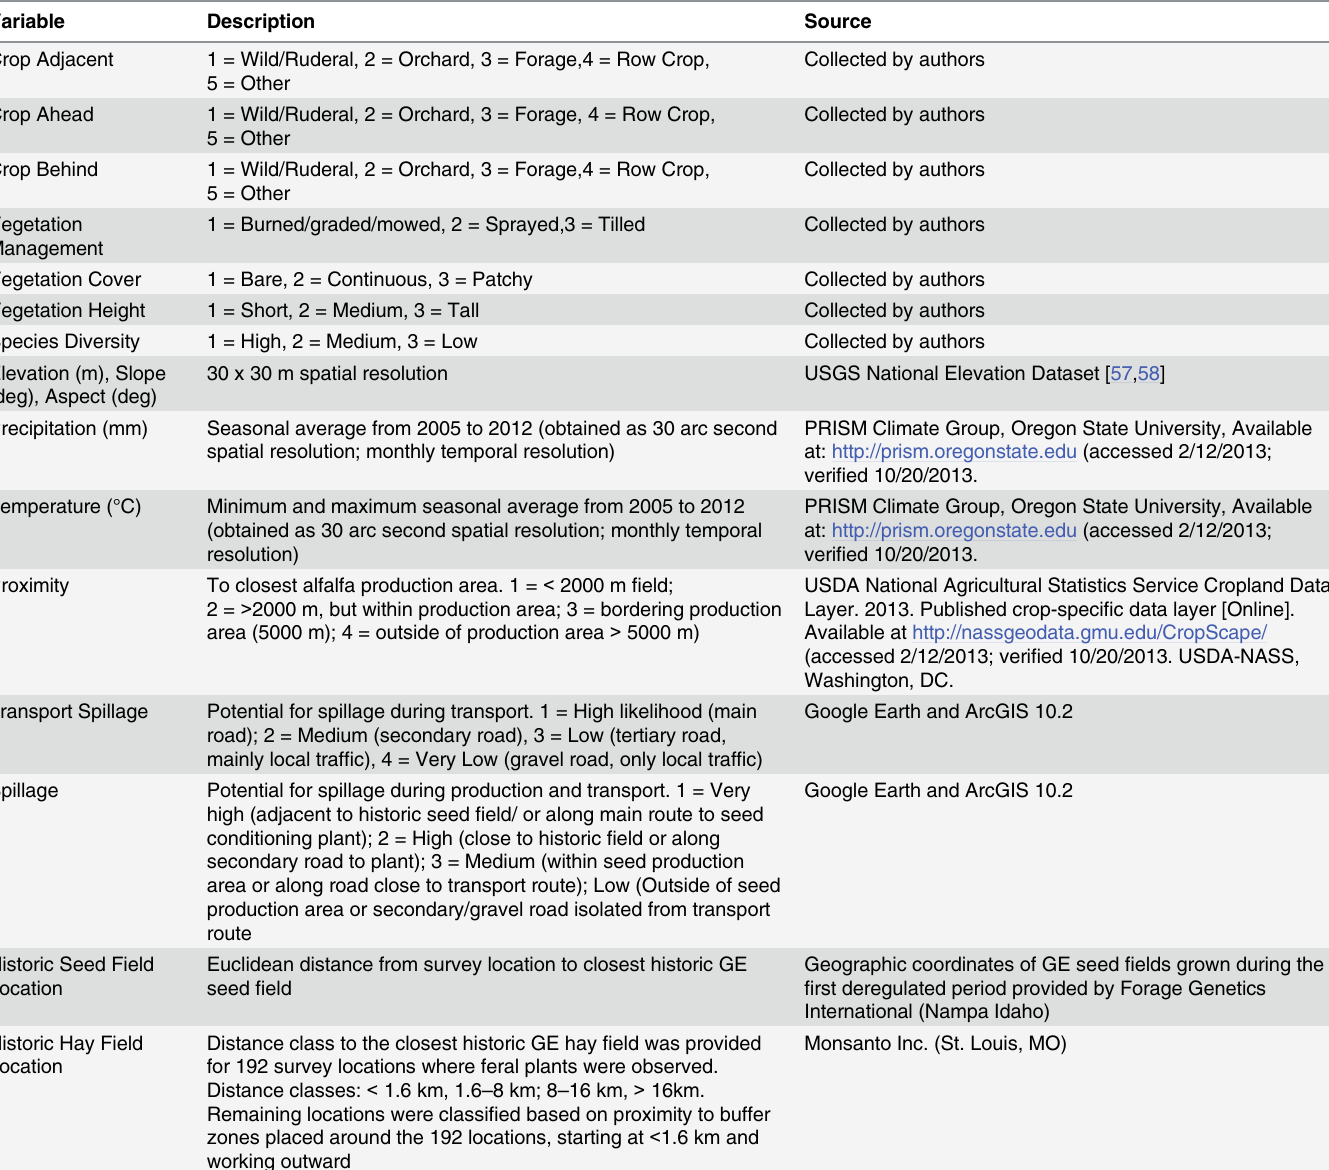
Table 2. Variables used in generalized linear model explain the occurrence of feral populations and transgenic feral populations growing along rural road